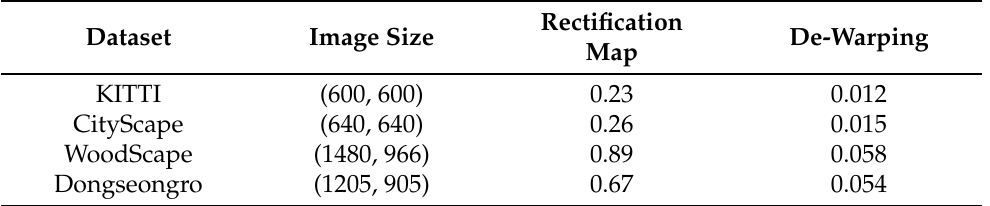
Table 17. Computation time of Expandable Spherical Projection. Rectification map is generated only one time at the start of the program.